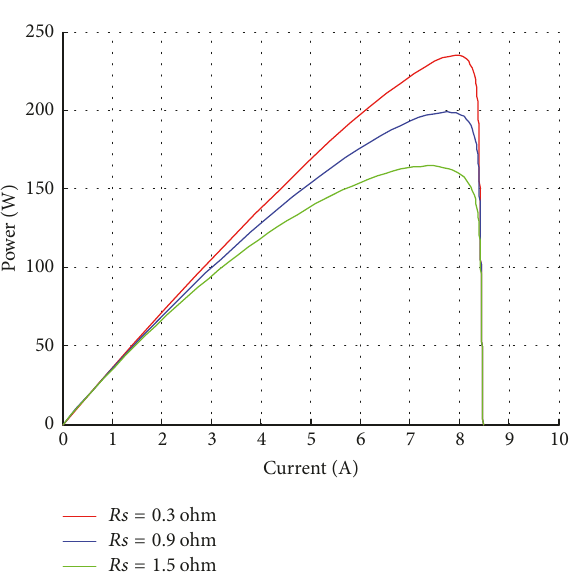
Figure 13: 𝑃 - 𝐼 curves for different 𝑅 s